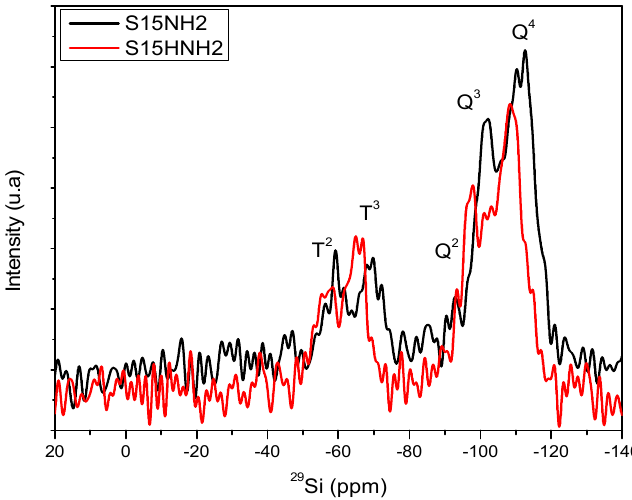
Figure 13. 29 Si NMR (HPDEC) spectra of solids modified on the surface via APTES: S15NH 2 and S15HNH 2 substrates.